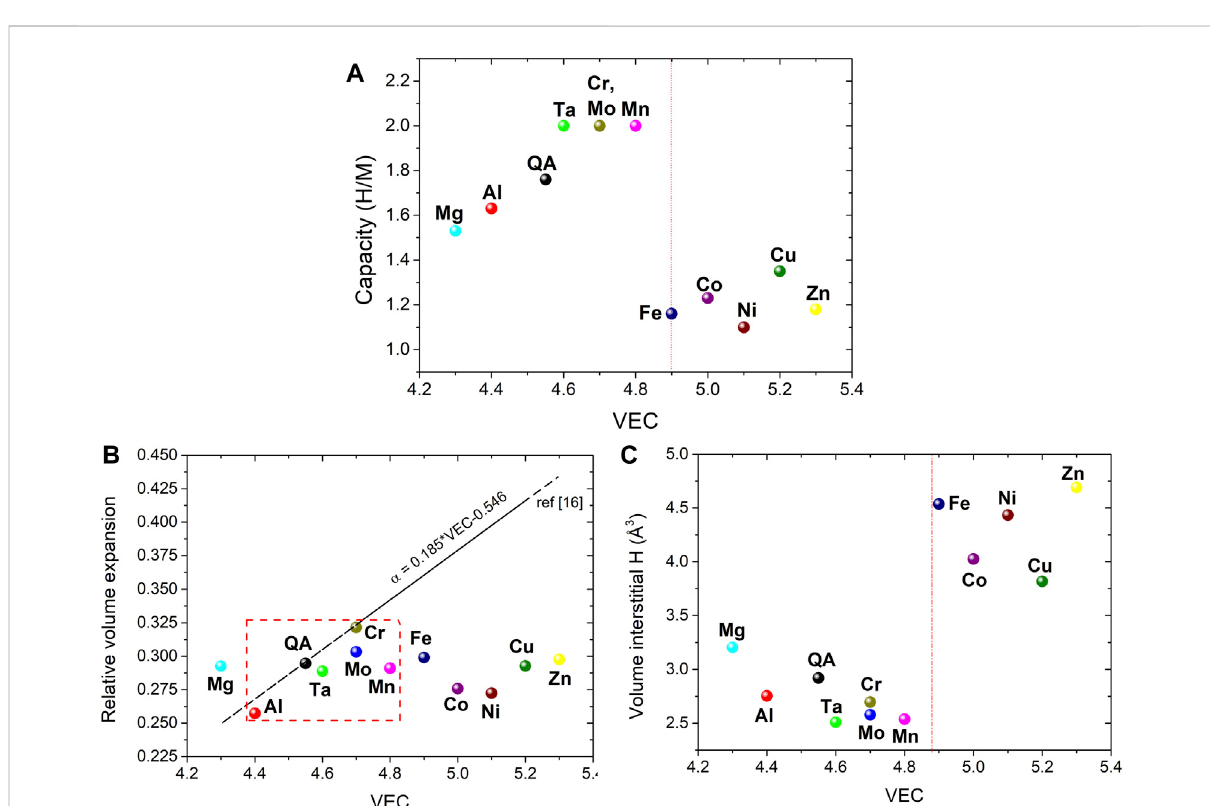
FIGURE 6 Thehydrogenstoragecapacity (A) ,therelativevolumeexpansionpermetalatom (B) andthevolumeofinterstitialH (C) versusVECfortheseries of the Ti 0.30 V 0.25 Zr 0.10 Nb 0.25 M 0.10 alloys with M = Al, Cr, Mn, Fe, Co, Ni, Cu, Zn, Mo, and Ta as well as the quaternary pristine alloy (QA). For comparison, the linear correlation proposed earlier by Nygård et al. (2019a) is also shown as dotted line in the B graphic. The red dotted square indicated the arc melting prepared